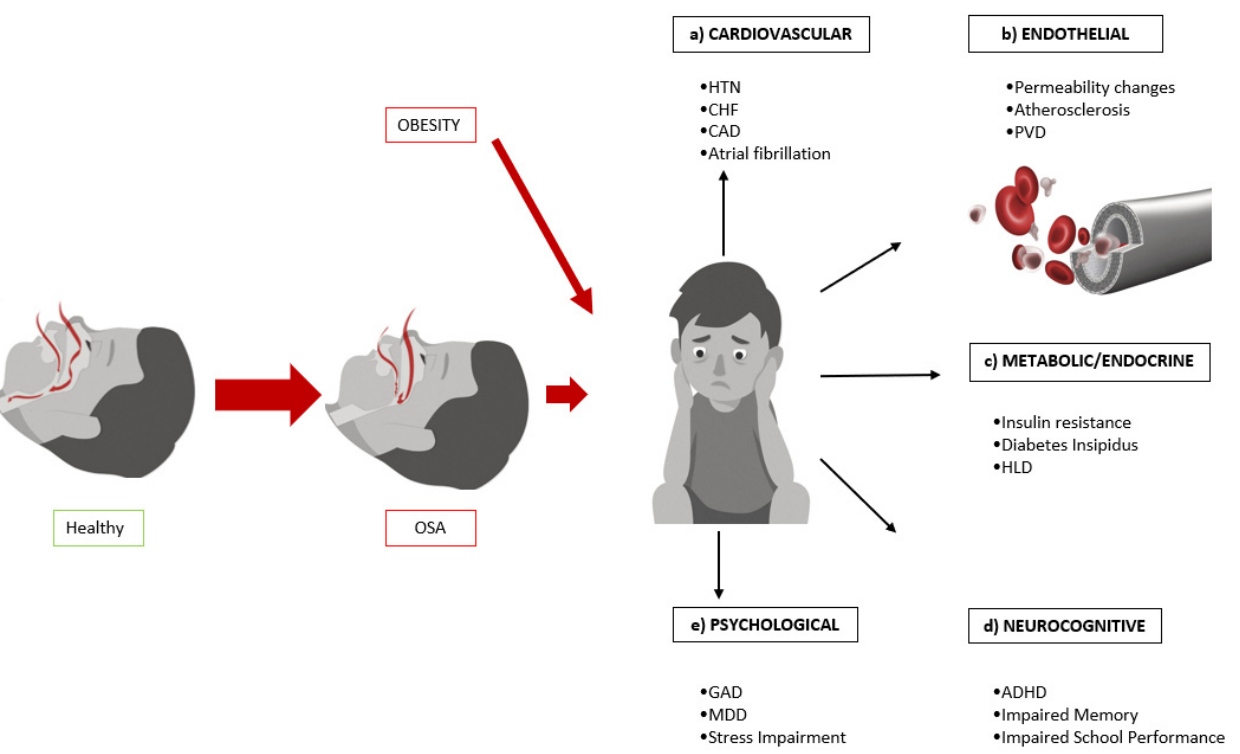
Figure 1. Sequelae of pediatric obstructive sleep apnea. ( a ) HTN = hypertension; CHF = congestive heart failure; CAD = coronary artery disease. ( b ) PVD = peripheral vascular disease. ( c ) HLD = hyperlipidemia. ( d ) ADHD = attention-deficit/hyperactivity disorder. ( e ) GAD = generalized anxiety disorder; MDD = major depressive disorder.